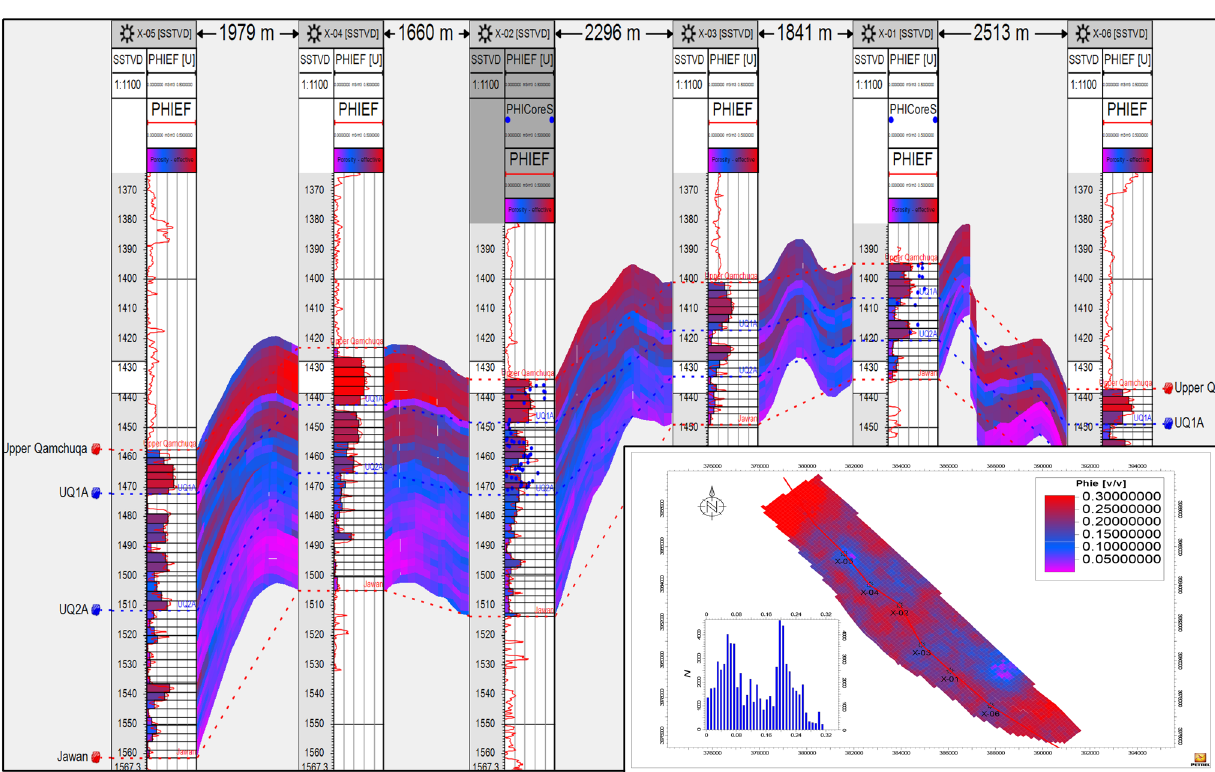
Fig. 4 Matrix porosity